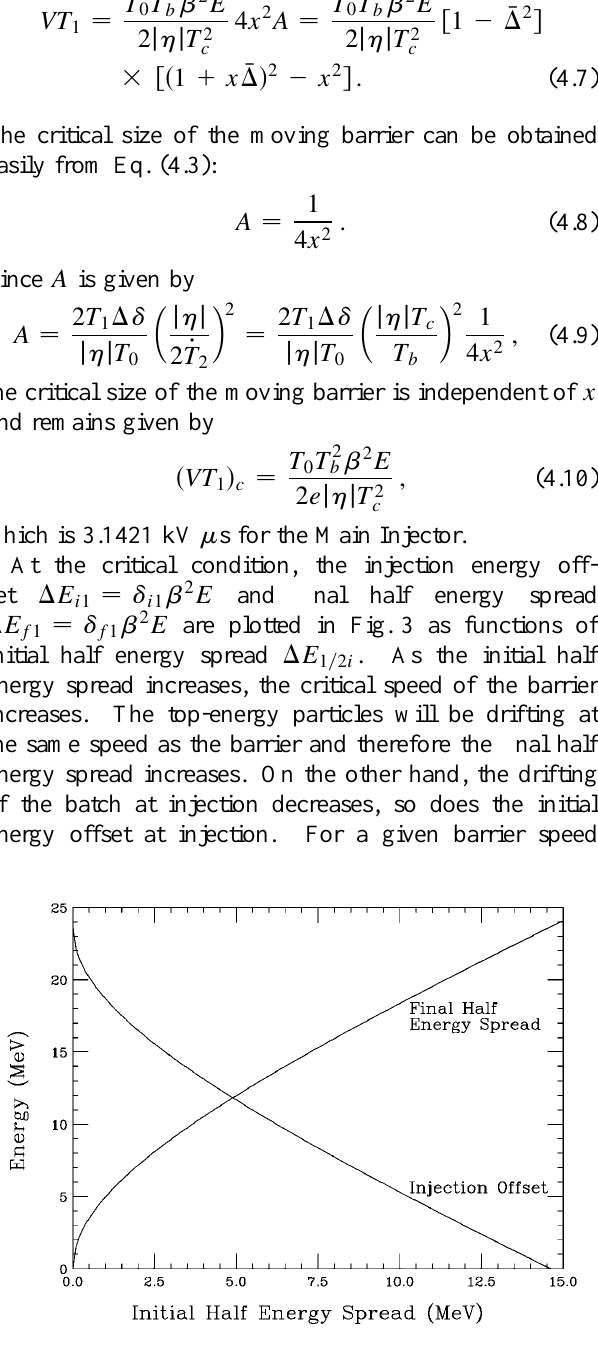
FIG. 3. At the critical condition, the initial energy offset at injection D E i 1 (cid:1) d i 1 b 2 E and final half energy spread D E f 1 (cid:1) d f 1 b 2 E versus the initial half energy spread of the booster